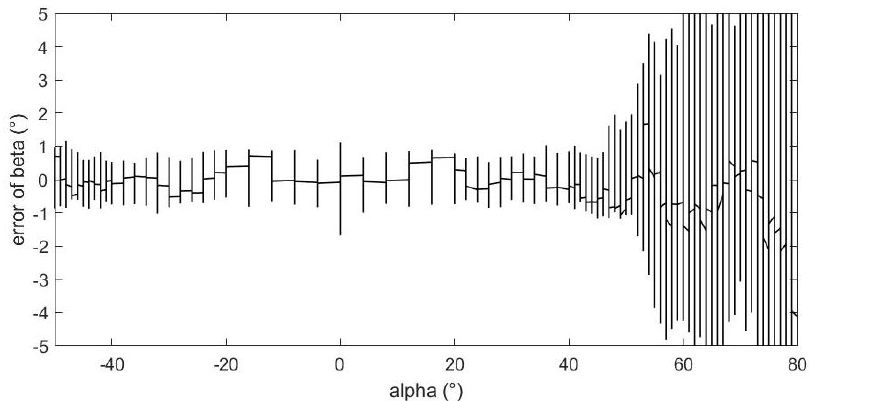
Figure 15. The relationship between sideslip angle estimation error and angle of attack